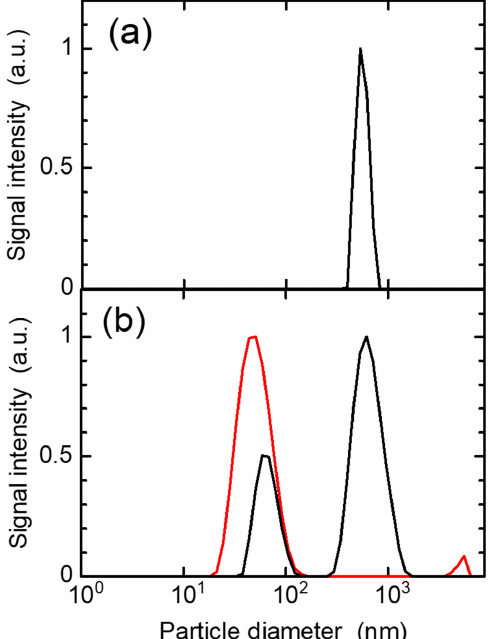
Figure 2. Light scattered intensity of 0.1 wt.% HGHGH aqueous solution ( a ) unirradiated and ( b ) irradiated with 10 kGy γ -rays with (black) and without (red) internal standard. The dose dependence of the nanoparticle size of the three peptides in γ -ray irradia- tion was next investigated (Figure 3). The particle diameters of YGYGY and FGFGF in- creased with the increasing absorbed dose, while that of HGHGH was almost constant or decreased at doses ˃ 5 kGy. The rate constants of these peptides with ·OH radicals were higher in the order FGFGF ˃ YGYGY ˃ HGHGH (Table 2); however, their particle size was higher in the order YGYGY ˃ FGFGF ˃ HGHGH. The formation of the peptide parti- cle is considered to be affected not only by the rate constant but also the aggregation based on their hydrophobicity. The particle size range of YGYGY was controlled in the range 130–550 nm by the absorbed dose, while that of FGFGF was 140–220 nm. As mentioned above, the polydispersity of each particle is low. However, the variation of particle size increased with higher dose, i.e., longer irradiation time. It is considered to be due to ag- gregation caused by the lower surface charge and hydrophobic interactions. In this case the bimolecular reaction of YGYGY was considered to occur more effectively than that of